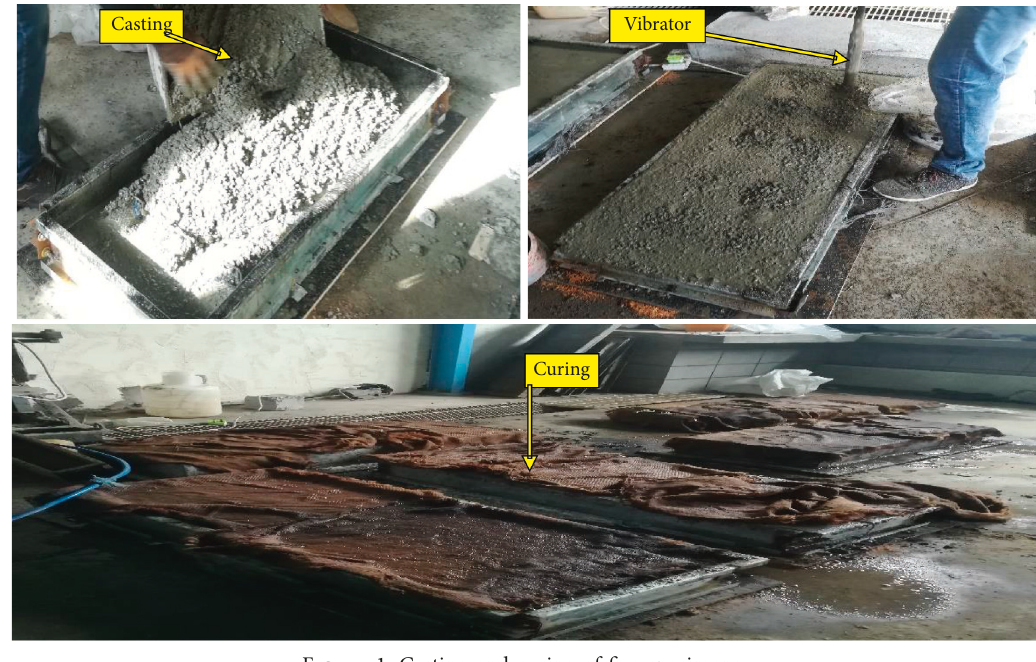
Figure 1: Casting and curing of five specimens.